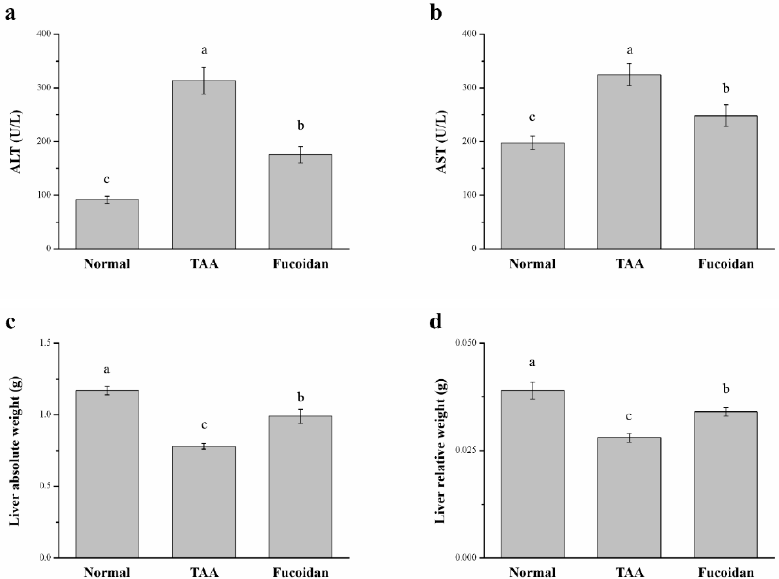
Figure 2. Changes in the ( a ) serum alanine aminotransferase (ALT) levels, ( b ) serum aspartate aminotransferase (AST) levels, ( c ) absolute weights, and ( d ) body weight-normalized weights (%) of the livers in normal mice, mice with TAA-induced liver injury, and fucoidan-treated mice with TAA-induced liver injury over a period of 42 days. All data are presented as the means ± SEMs ( n = 10). a–c Data with different letters in the columns are significantly different with one-way ANOVA, and the means of different groups were compared by Duncan’s test at p < 0.05.